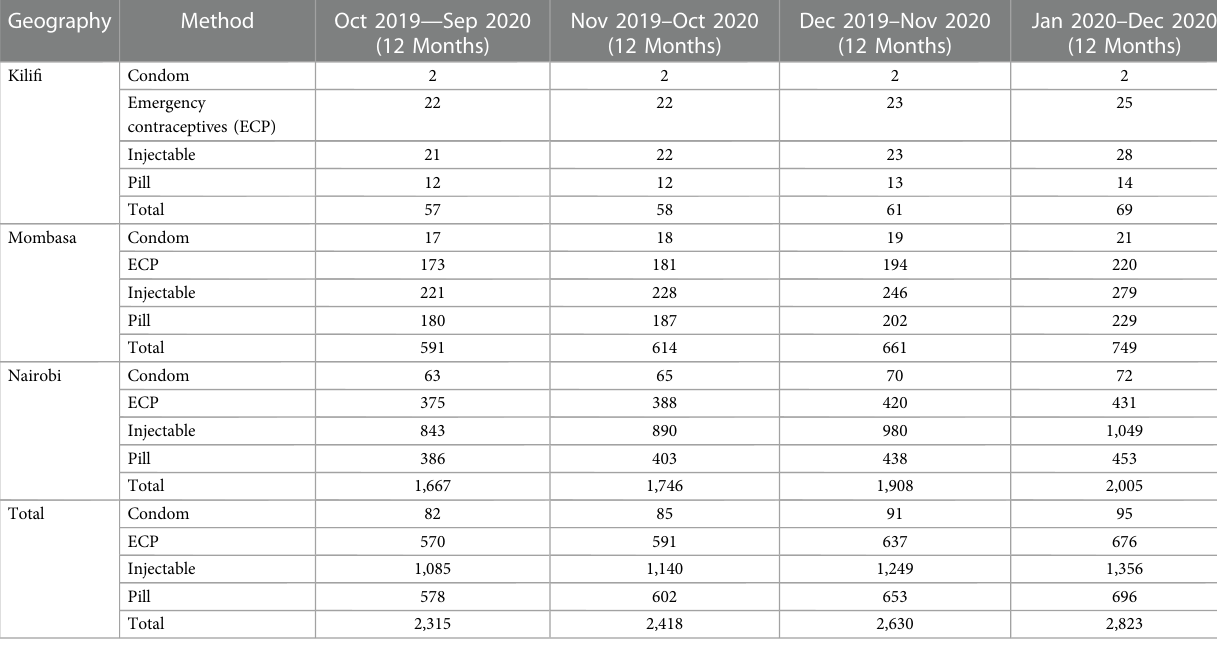
TABLE 3 Annual contraceptive client volume and methods (October 2019 to December 2020).